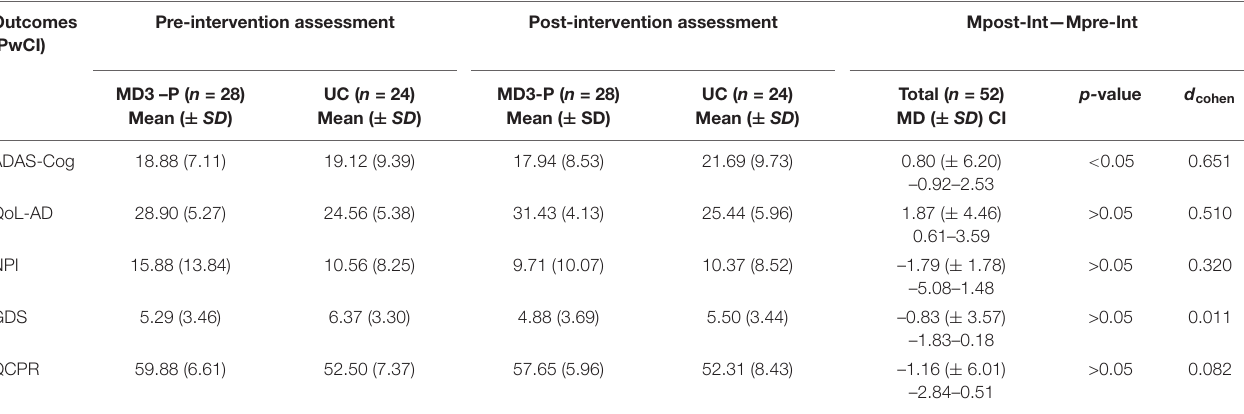
TABLE 4 | Mean outcome scores for MD3-P and UC groups and total pre- and post-intervention mean differences for PwCI. Outcomes